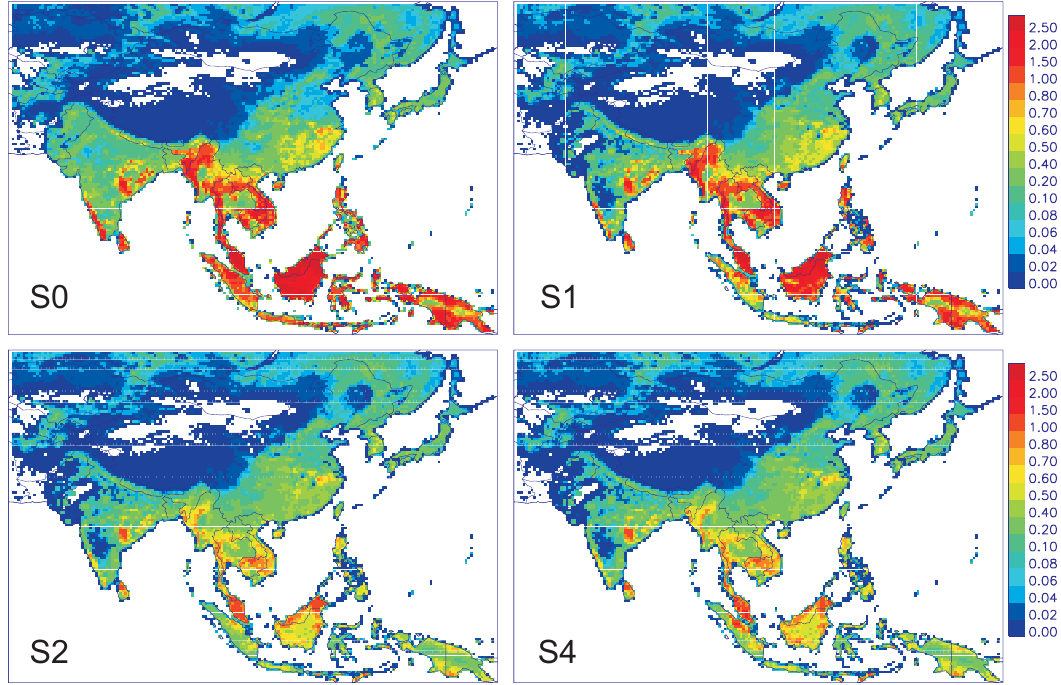
Fig. 8. Annually averaged isoprene emission rates computed in the S0, S1, S2 and S4 simulations for 2005. S1 accounts for land-use change effects, S2 also incorporates reduced emission rates from tropical forests, and S4 includes both updates in solar radiation and in the representation of oil palm in Indonesia and Malaysia (Table 1). The S4 simulation is identical to S3 over Indonesia and Malaysia.